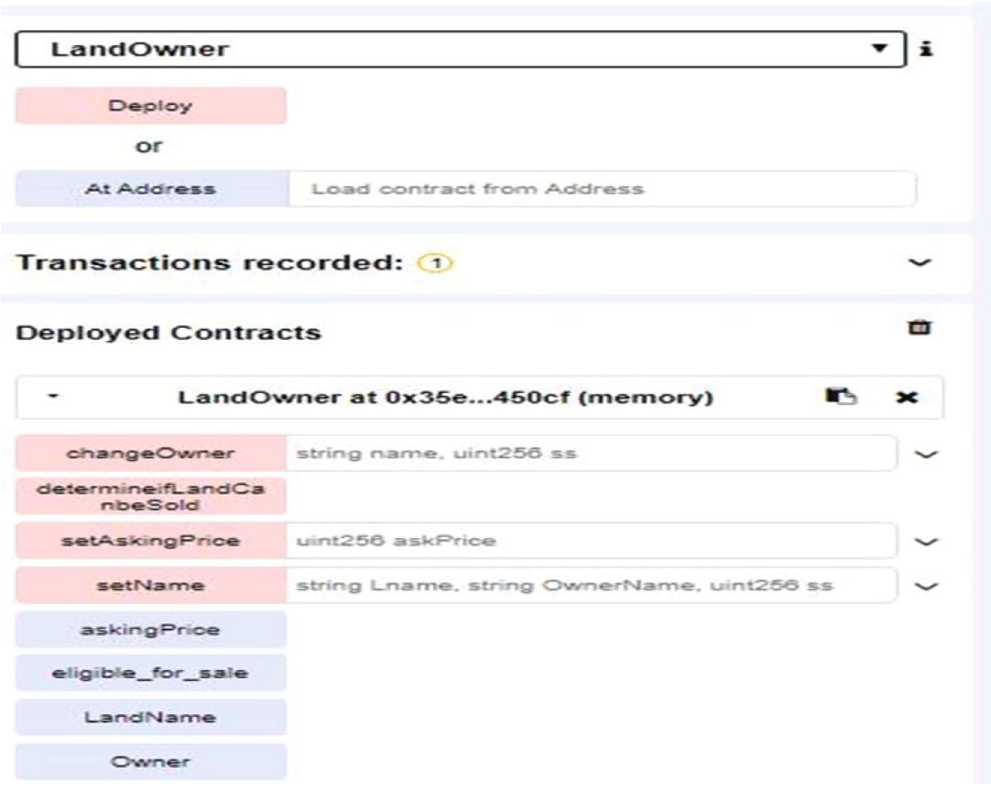
Figure 16: State transition in blockchain after